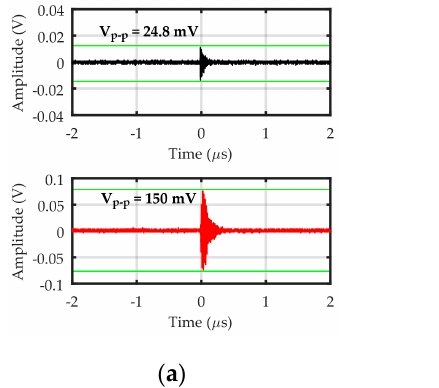
Figure 11. The comparison of the exemplary UHF pulses registered by the commercial UHF disk antenna and prototype meandered PIFA for ( a ) surface PD of an apparent charge of q = 625 pC, ( b ) creeping spark of apparent charge of q = 4670